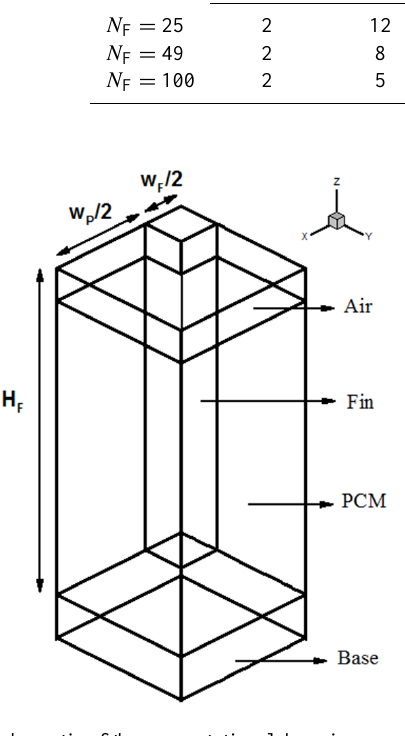
Figure 2. Schematic of the computational domain.